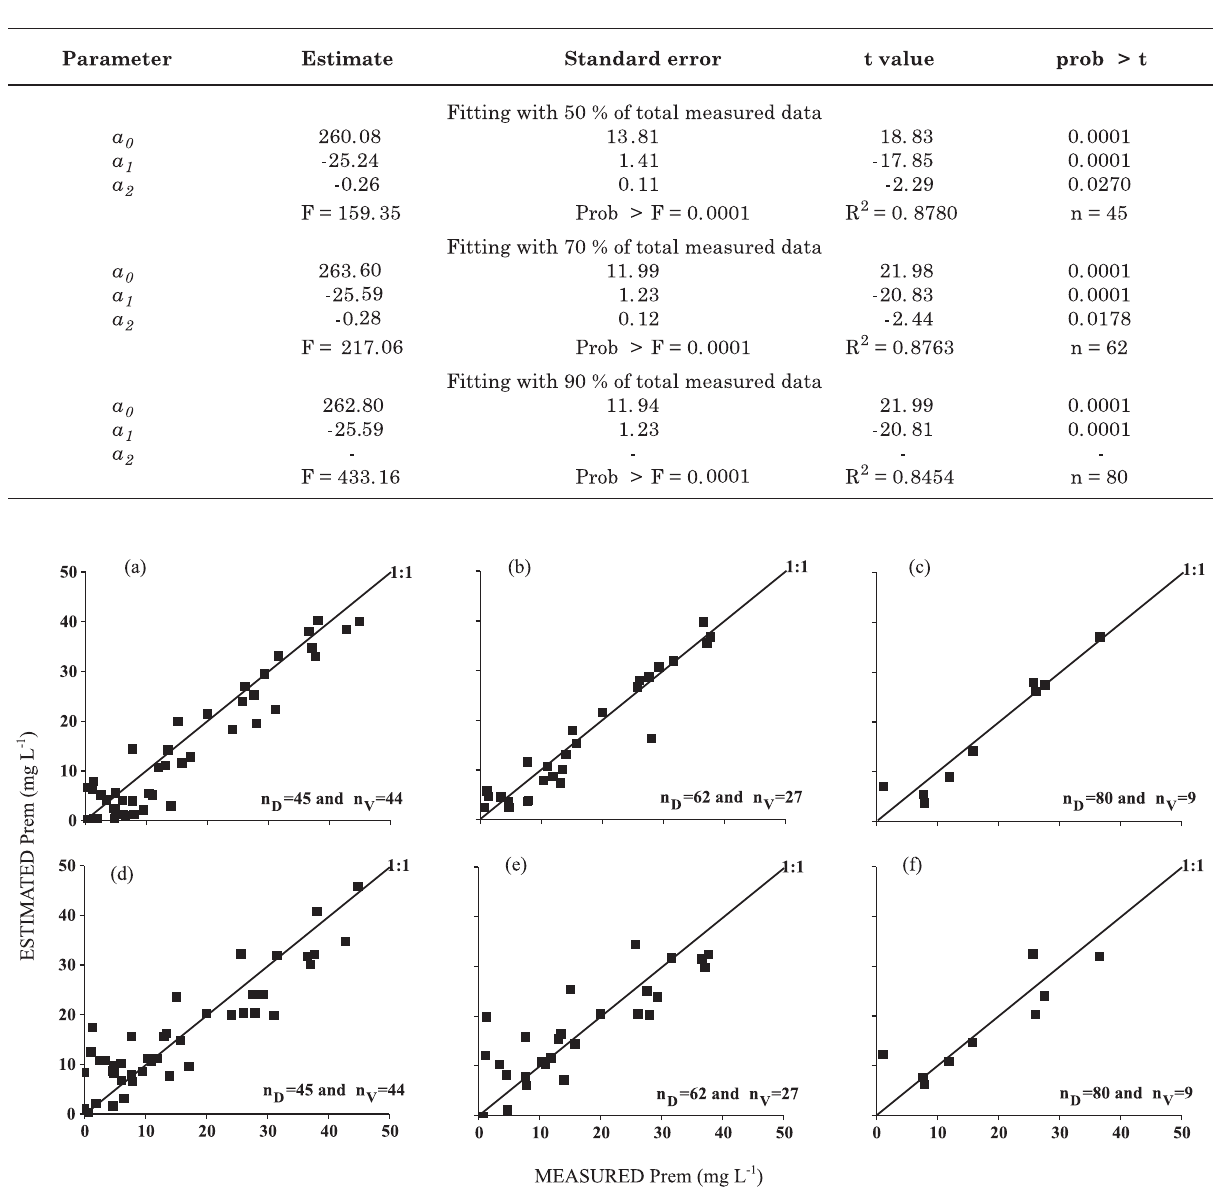
Figure 1. Scatter diagrams relating the measured remaining phosphorus (Prem) to the estimated values by the artificial neural network (a, b, c) and by multiple regression analysis (d, e, f). n in the development of the pedotransfer function; n pedotransfer function.